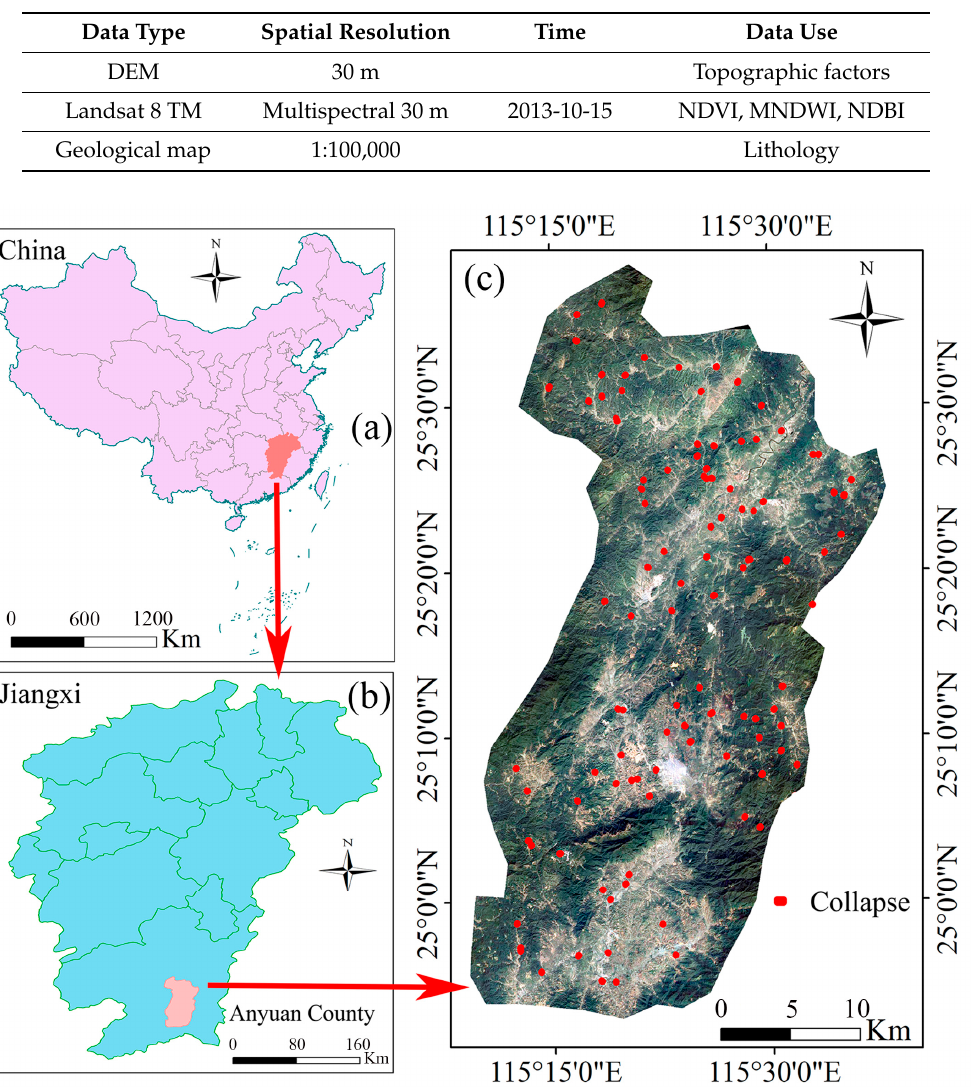
Table 1. Data sources for collapse susceptibility prediction.